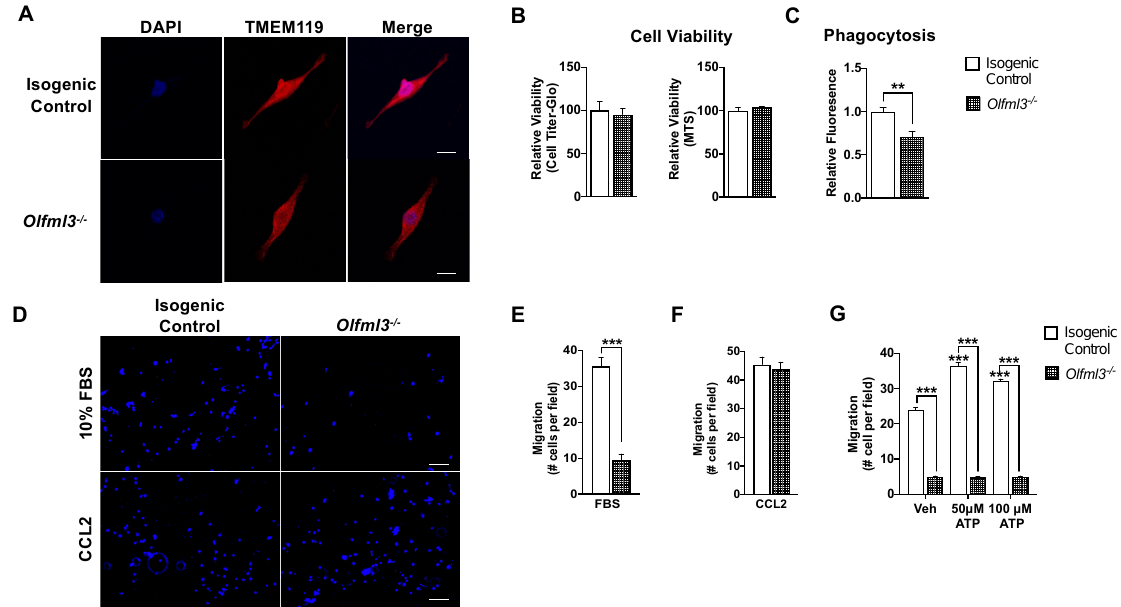
Figure 3. Loss of Olfml3 impairs microglial phagocytosis and chemotaxis. ( A ) There were no morphological differences detected between isogenic control and Olfml3 -/- microglia; scale bar 5 µm. ( B ) Cellular viability, as assayed by Cell Titer- Glo ® ( p = 0.53) and MTS ( p = 0.27) assays, was not altered following deletion of Olfml3 in N9 microglia. ( C ) Microglial phagocytosis of pHrodo TM Escherichia coli bioparticles was reduced by 30% in Olfml3 -/- microglia relative to isogenic control cells. Comparisons based on students t-test; ** p < 0.01. ( D ) Representative images of isogenic control and Olfml3 -/- microglial migration toward fetal bovine serum (FBS; 10%) or human recombinant C-C motif chemokine ligand 2 (rhCCL2; 10 ng/mL); scale bar 20 µm. ( E ) Loss of Olfml3 markedly attenuated microglial migration toward FBS relative to isogenic control cells. Comparisons based on students t -test; *** p < 0.001. ( F ) The rhCCL2 elicited equivalent chemotaxis between isogenic control and Olfml3 -/- N9 cells. Comparisons based on students t -test; p = 0.54. ( G ) Chemotaxis toward ATP (50 µM, 100 µM) increased relative to vehicle in isogenic control, but not Olfml3 -/- , microglia. Comparisons based on one-way ANOVA with Tukey’s Multiple Comparison Test; *** p < 0.001. Bars represent group mean with standard error of the mean (SEM); data represent one of three independent experiments.